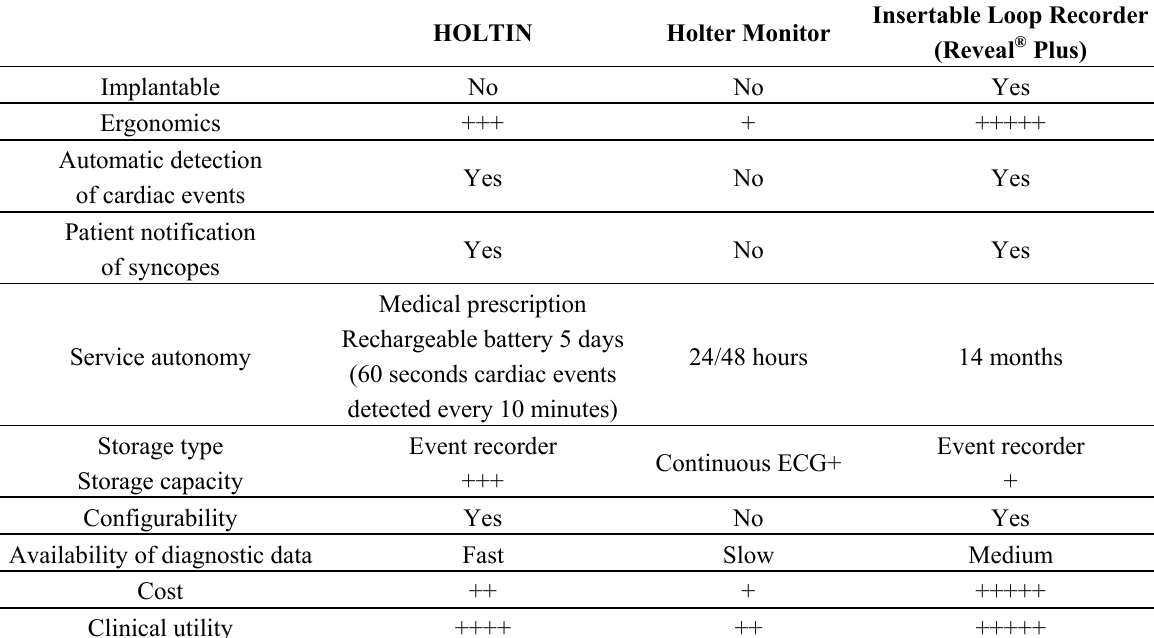
Table 1. Comparison of Features and Functionalities found in AECG